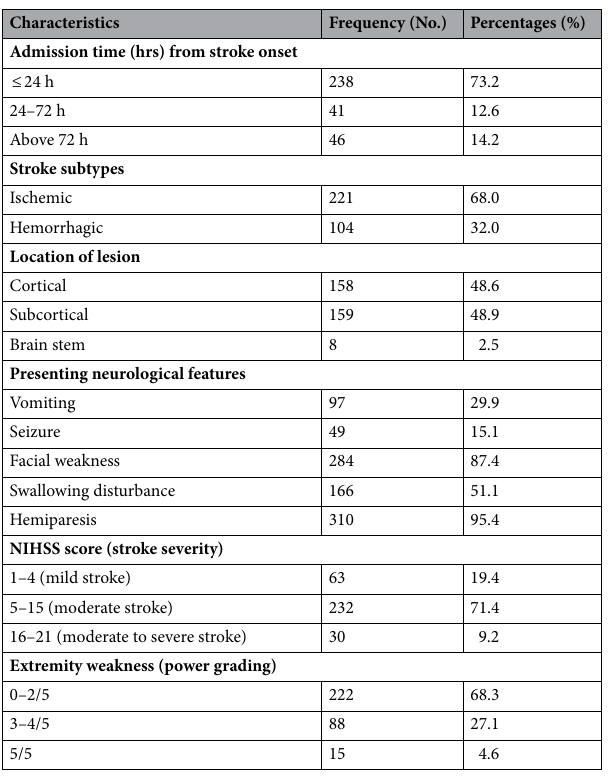
Table 2. Neurological characteristics of adult stroke patients admitted to the Stroke Care Unit, University of Gondar hospital, January 1 to December 31, 2020. (n = 325).